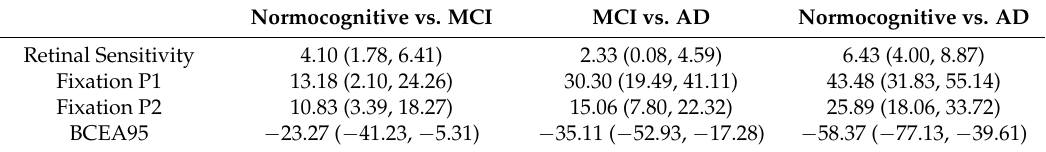
Figure 2. Representative examples of the fixation graph close to the median BCEA95 value of a normocognitive ( a ) (BCEA95 3.1°), MCI ( b ) (BCEA95 34.7°) and AD ( c ) (BCEA95 40.4°) subject. The green and the orange bands represent a circle of 1 and 2 degrees respectively. Table 2. Pairwise comparison analysis (contrast and 95% confidence interval).